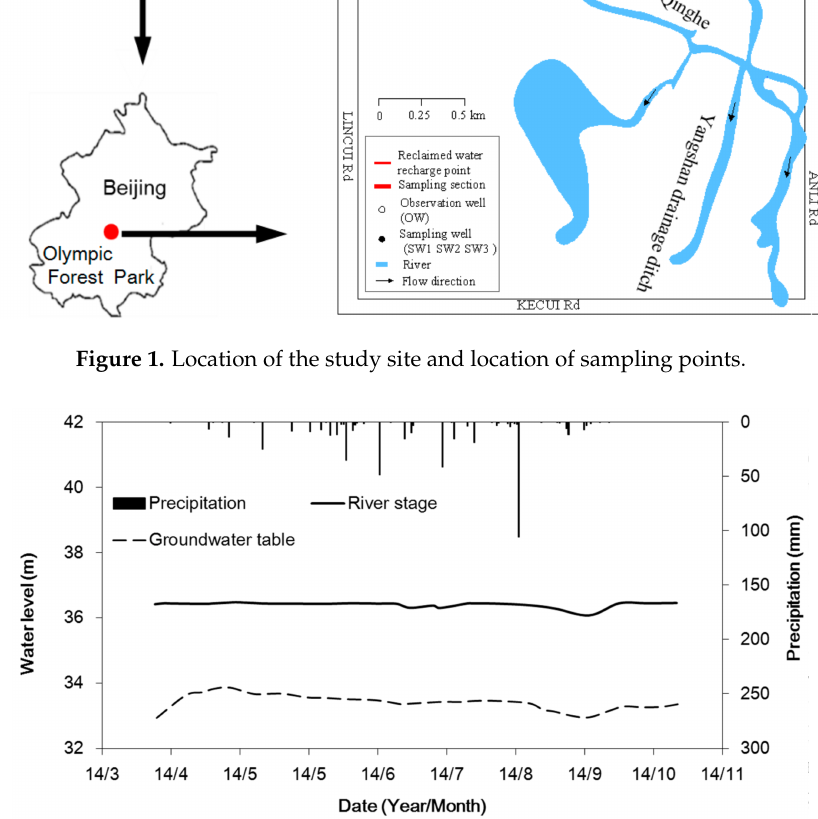
Figure 2. Variation of the river stage and groundwater table in sampling well 3 and precipitation from March to November in